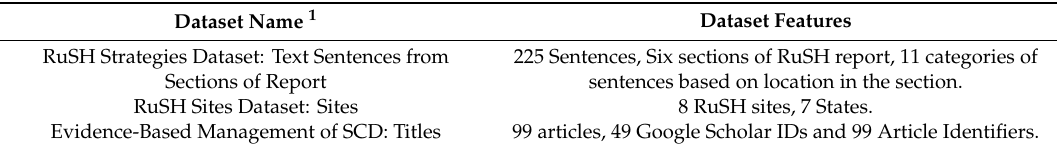
Table 1. Datasets constructed for understanding public and clinical aspects of sickle cell disease.